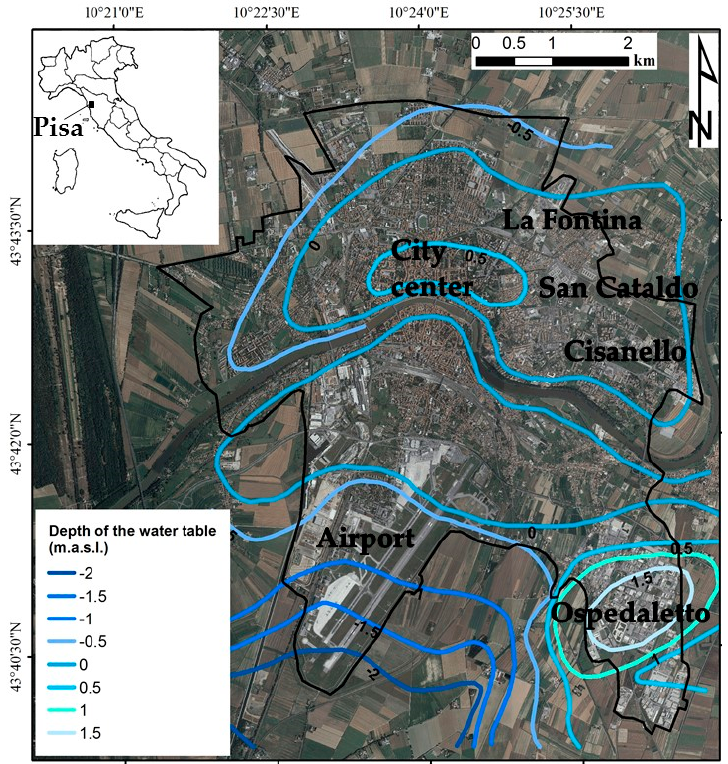
Figure 1. Geographical framework of the area of interest and the phreatic surface in the urban area of Pisa (from [45]). The black line represents the urban area. The contour map is overlaid on a 2010 digital orthophoto.